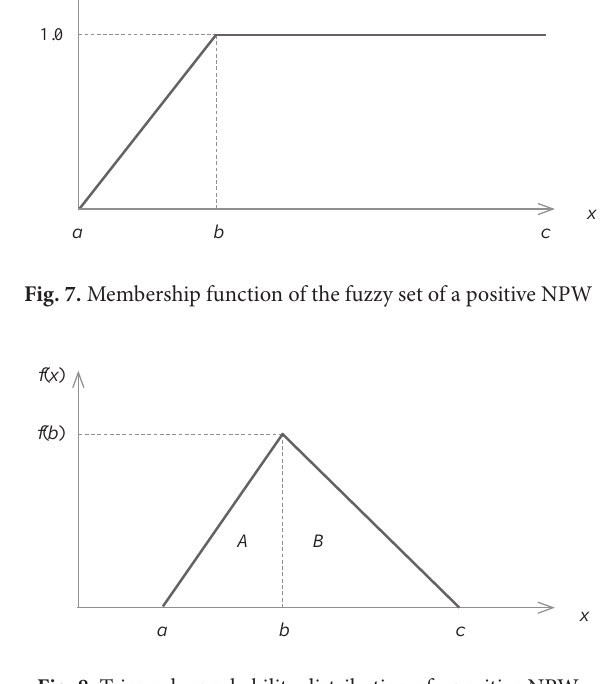
Fig. 8. Triangular probability distribution of a positive